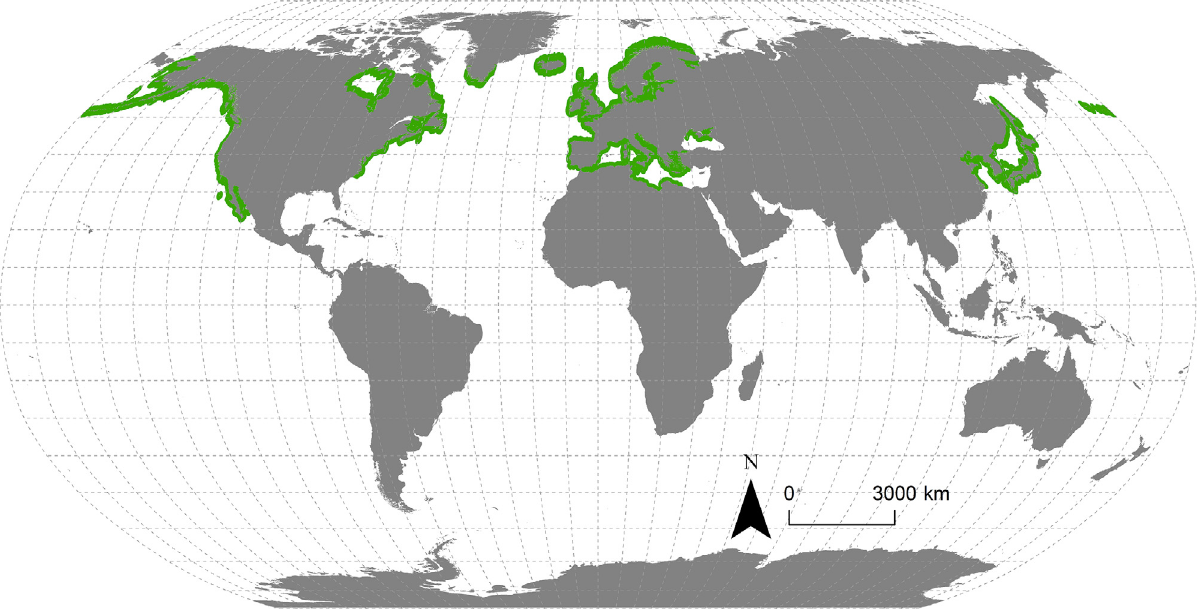
Fig. 1. Global distribution of eelgrass (green shading). Data obtained from IUCN Red List of Threatened Species